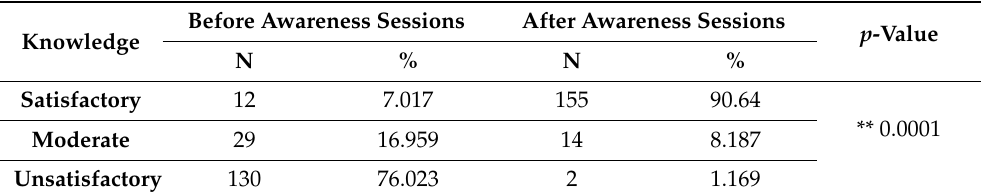
Table 4. Percentage distribution of nurse managers’ knowledge about inclusive leadership before and after awareness sessions ( n =